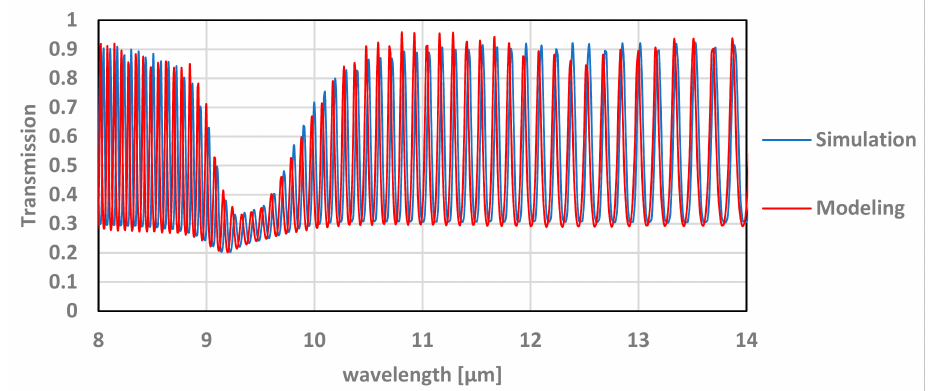
Figure 6. Simulation and modeling of transmission results as a function of the wavelength.